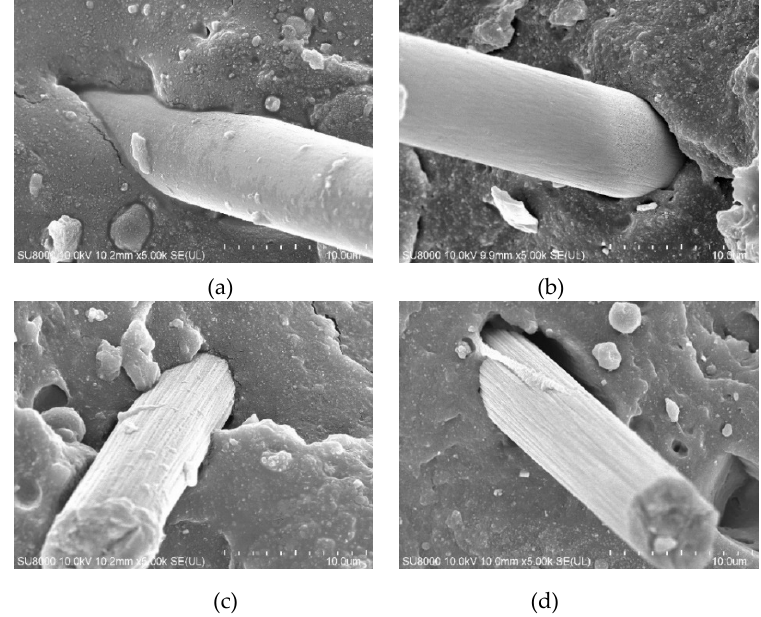
Figure 4. SEM pictures of CF in natural rubber (NR) and natural rubber latex (NRL): ( a ) SEM pictures of NRL/CF; ( b ) SEM pictures of NR/CF; ( c ) SEM pictures of NRL/CF; ( d ) SEM pictures of